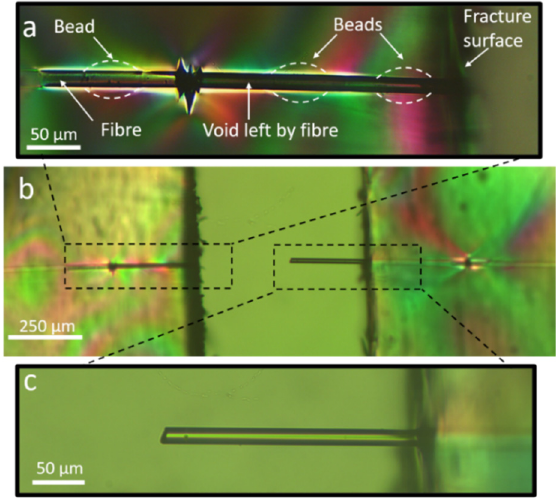
Figure 6. Fibre pullout from single fibre fragmentation test of beaded fibres. The beads are marked out with white dotted lines. The beads stay in the matrix ( a ) and are not pulled out with the fibre ( c ). The fibre and matrix are seen side-by-side in ( b ).